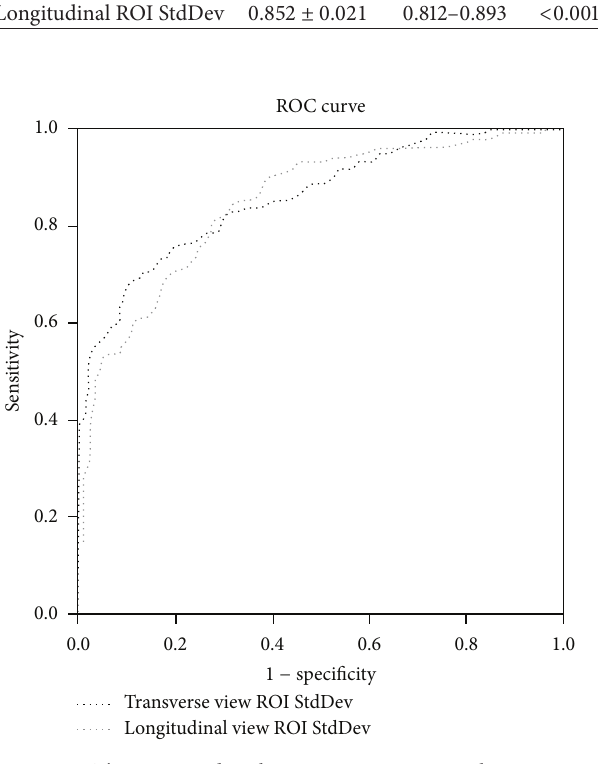
Figure 2: The area under the receiver operating characteristic (AUROC) curves depicting the sensitivity and specificity of biceps tendinitis by using the grayscale standard deviation (StdDev) values in the ROI from the transverse and longitudinal